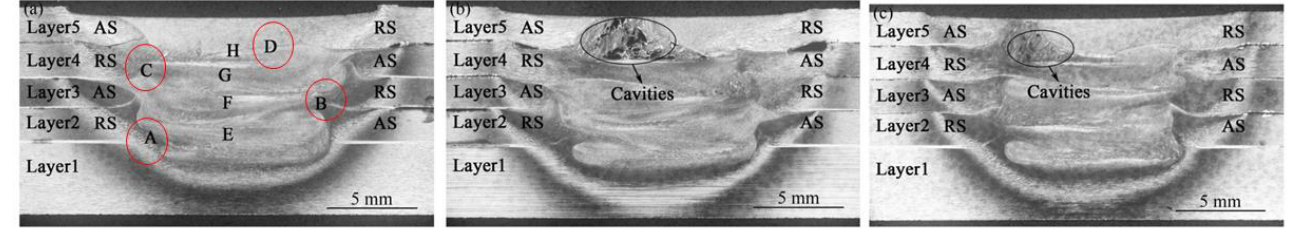
Figure 10. Hooking and kiss bonding defect in the identical material 7N01-T4 aluminum alloy build fabricated through FSAM (reprinted from [73] with permission from Elsevier): ( a ) laminate cross- section; ( b ) magnified layer six, seven and eight; ( c ) magnified hook defect of layer seven and eight; ( d ) magnified hook defect of layer six; ( e ) magnified kissing bond defect of layer six and seven.